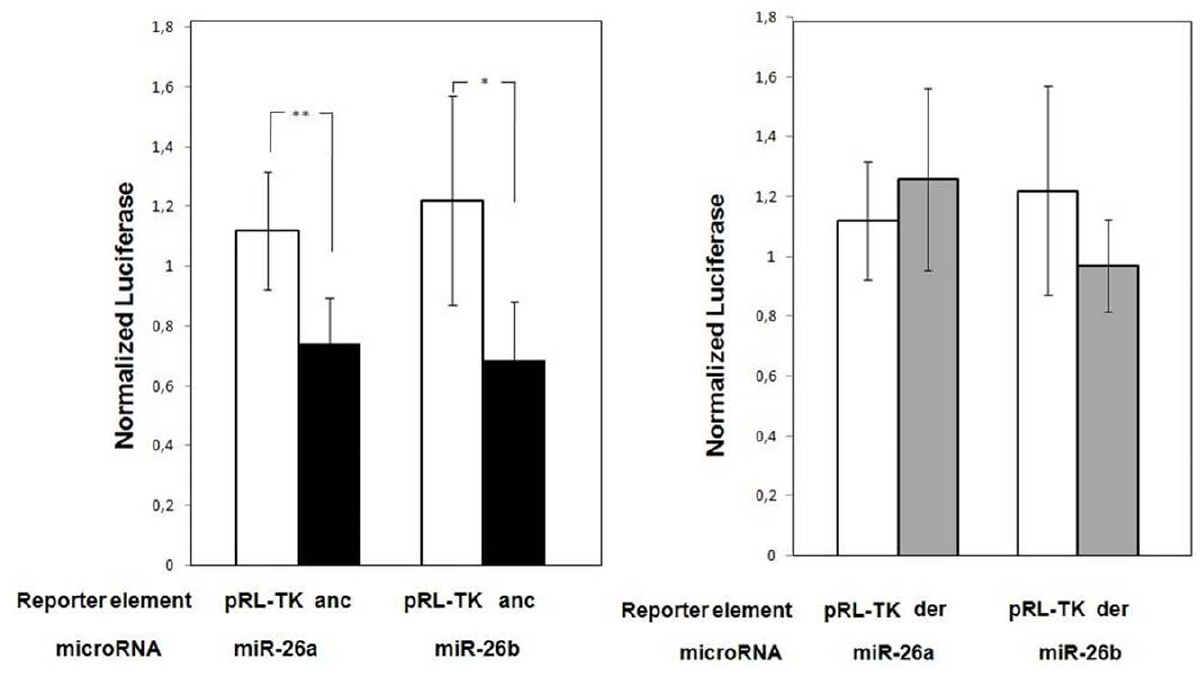
Figure 2. Luciferase assays for validation of miR-26a and -26b binding to BDNF 3 9 UTR. HeLa cells were independently transfected with control plasmid (pRL-TK) or each of the two reporter plasmid (pluc-BDNF C–G, anc, and pluc-BDNF A–T, der) with either miR-26a or miR-26b. Data are presented as the normalized activity of different reporter genes. Introduction of exogenous miR-26a and miR-26b represses reporter activity of pluc- BDNF C–G but has no effect on pluc-BDNF A–T. Data represent the mean of five independent experiments + SD ( p , 0.05).